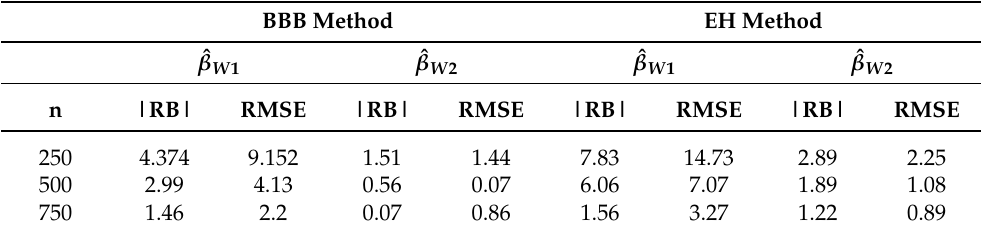
Table 1. Absolute relative bias and relative mean squared error in percent for ˆ β W 1 and ˆ β W 2 in SRSS for the BBB and EH